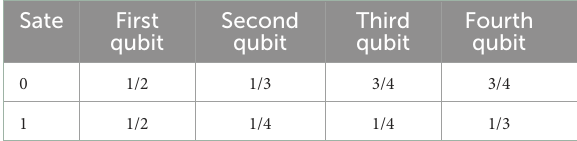
TABLE 2 The probability table for producing the state of each